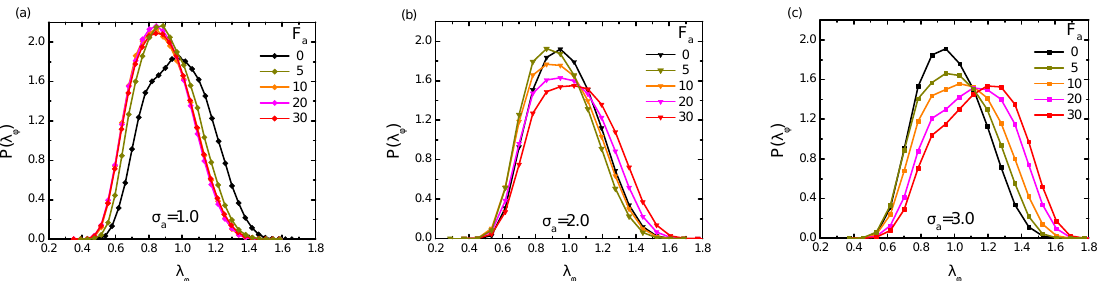
Figure 10. Profiles of distribution P ( λ φ ) under varying active forces, with three different crowder sizes: σ a = 1.0 ( a ); σ a = 2.0 ( b ); and σ a = 3.0 ( c ). The polymer’s rigidity is given as κ = 1.0, and the volume fraction of the crowders is fixed at φ =